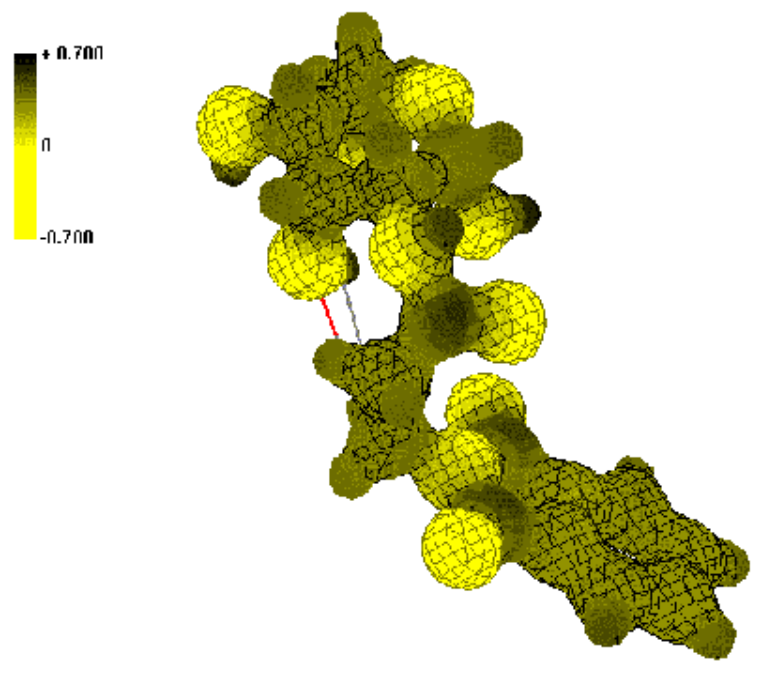
Figure 2. Isosurface of the electrostatic potential in the spatial vicinity of N-acyl-2-AG (4). Dark (black) colors indicate positive ESP regions and light (yellow) colors indicate negative ESP regions. Comparison of ESP of the N-alkanoyl-AG 2, 3 (Figure 1) with the N-phthalimidoalkanoyl-AG 4-8 (Figure 2) shows that for compounds 2, 3 increased positive charge regions located on the carbon atom of the amide bond, while derivatives 4-8 gets more positive ESP regions on the carbon atoms of the CO-N-CO fragment of the phthalimide